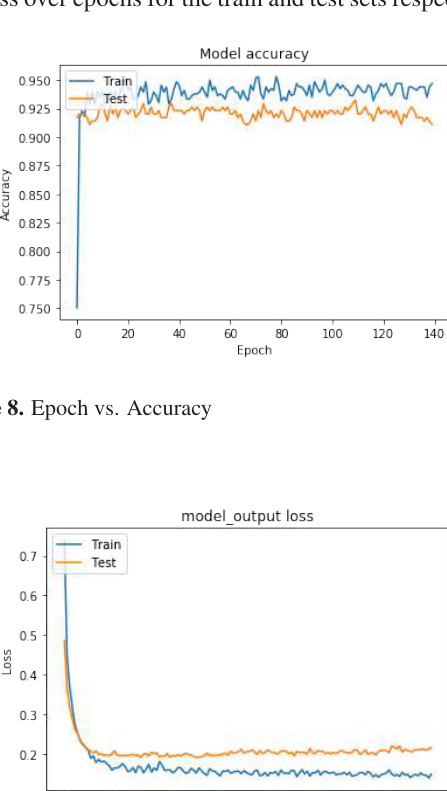
Figure 7. Comparison of expected and proposed model